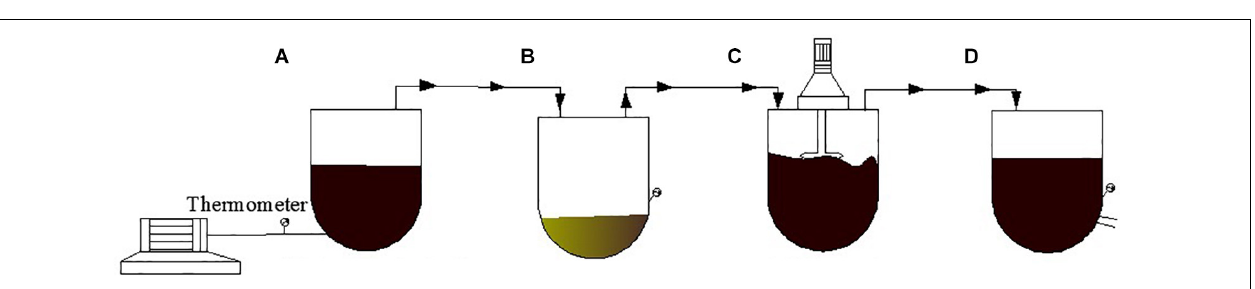
Frontiers in Materials |